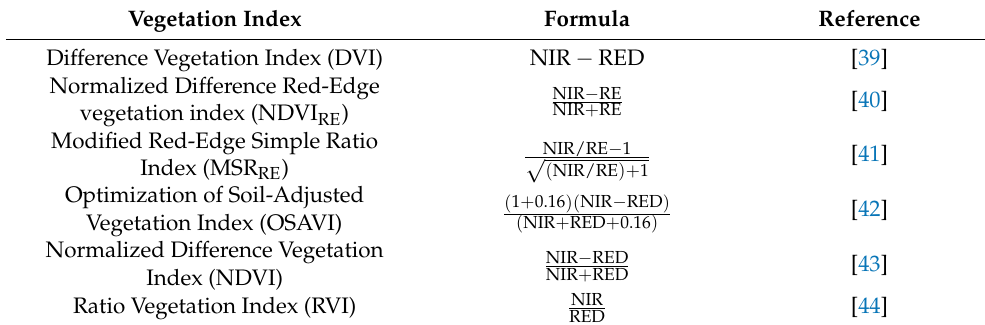
Table 3. Definition of the selected